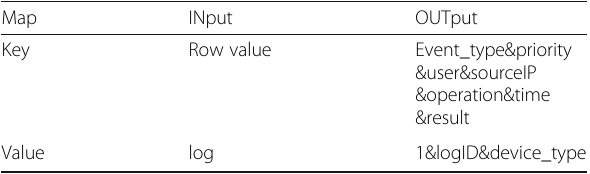
Table 3 The MAP phase input and output of the